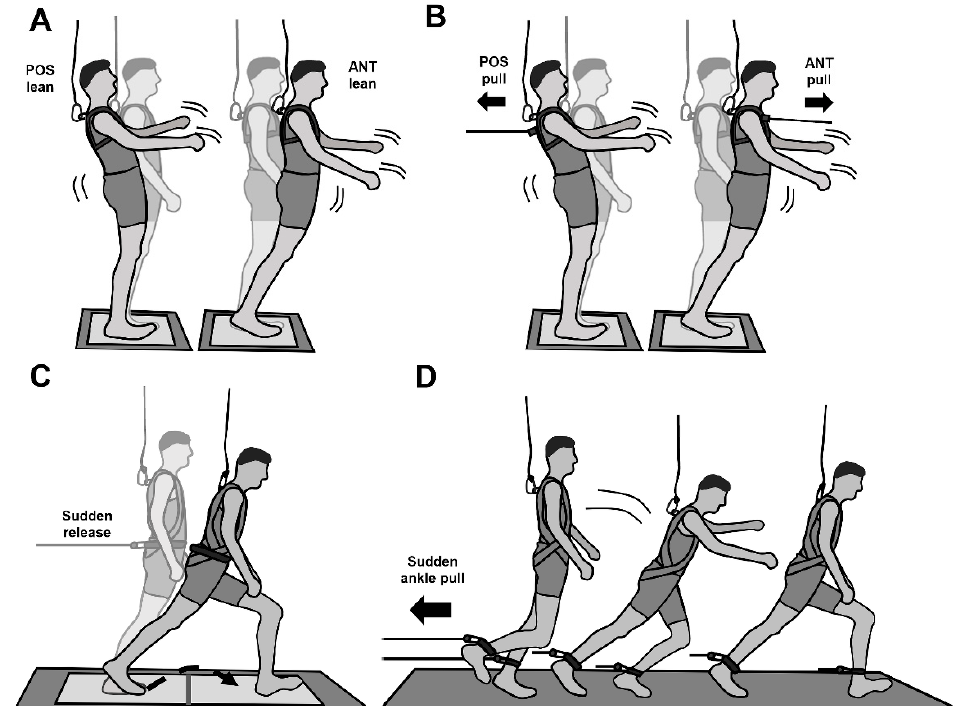
Figure 1. Illustration of analysed motor tasks. ( A ) Unperturbed standing: Assessment of the boundaries of the BoS (stability mechanism: counter-rotation). ( B ) Perturbed standing: Perturbation of standing in anterior and posterior directions with individually adjusted perturbation strengths (stability mechanism: counter-rotation). ( C ) Lean-and-release task with an inclination taking up 33% of body weight (stability mechanism: increasing BoS). ( D ) Perturbed walking: Simulated tripping while walking.